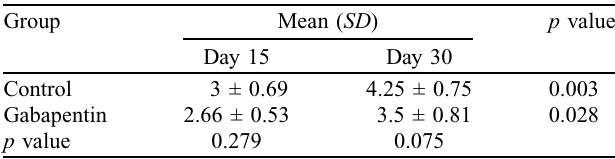
Table 1. Comparison of radiographic scores between the control and treatment